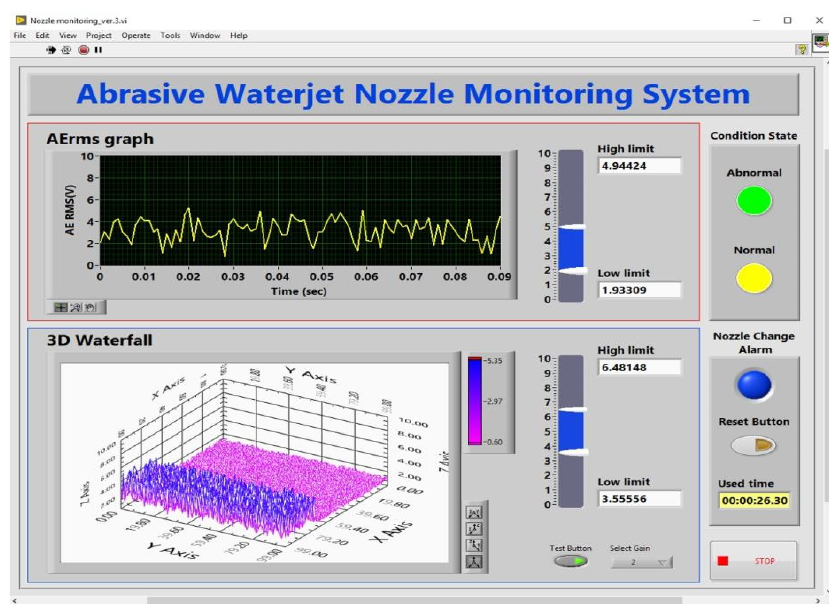
Figure 3. The program detecting wear, damage, and normal nozzle status.